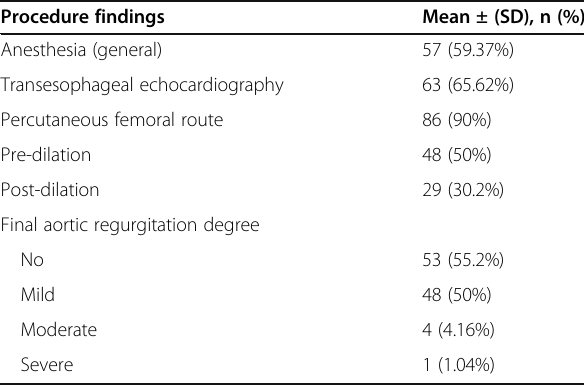
Table 4 Procedural details Procedure